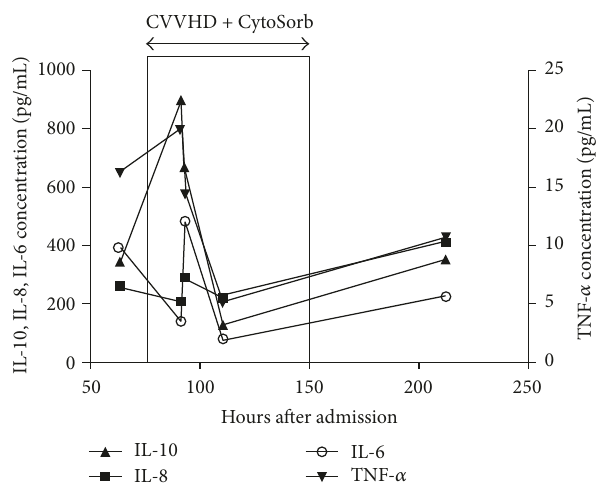
Figure 2: Course of proinflammatory and immunomodulatory cytokines before, during, and after combined CVVHD + CytoSorb